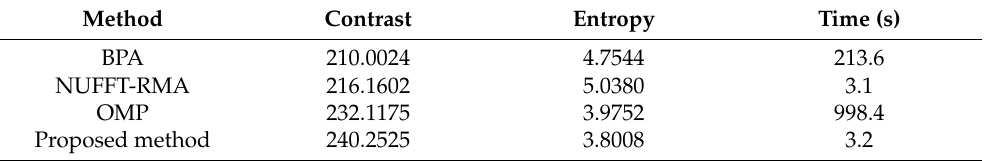
Table 4. Quality and time complexity.